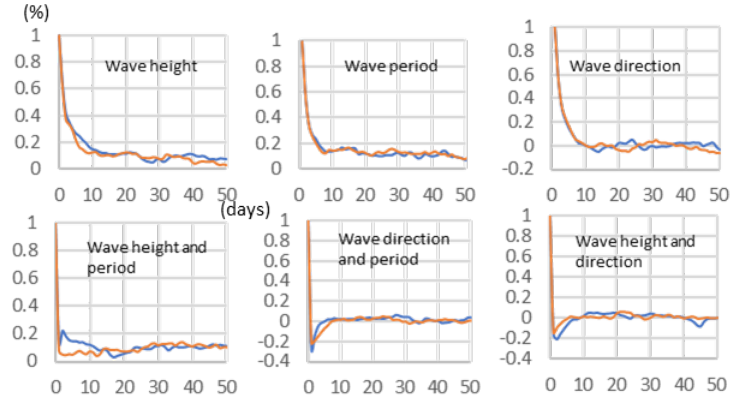
Figure 9. In the time period: 1 July 2003 to 31 March 2013, first row: autocorrelation up to 50 lags for each sea condition variable. Second row: cross-correlation between pairs of sea condition variables. Blue lines are the auto/cross correlation function of the original data, and the red lines correspond to those of the simulated data. Note: In all plots the horizontal axis is the lag time in days and the vertical axis is the normalised correlation value which lies between 1 and − 1.